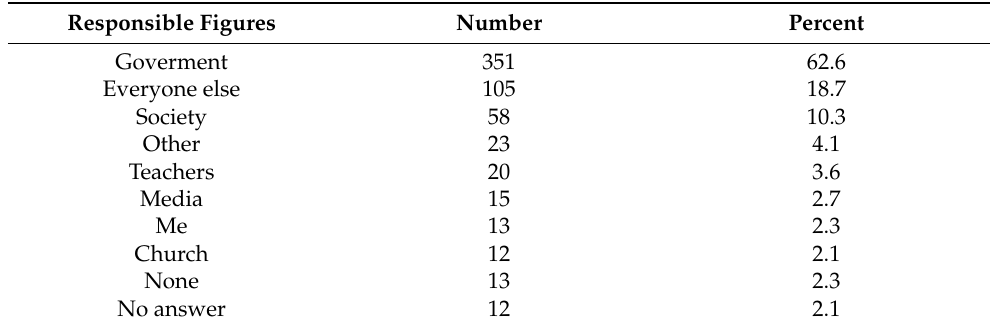
Table 7. National figures with responsibility to provide solutions to the